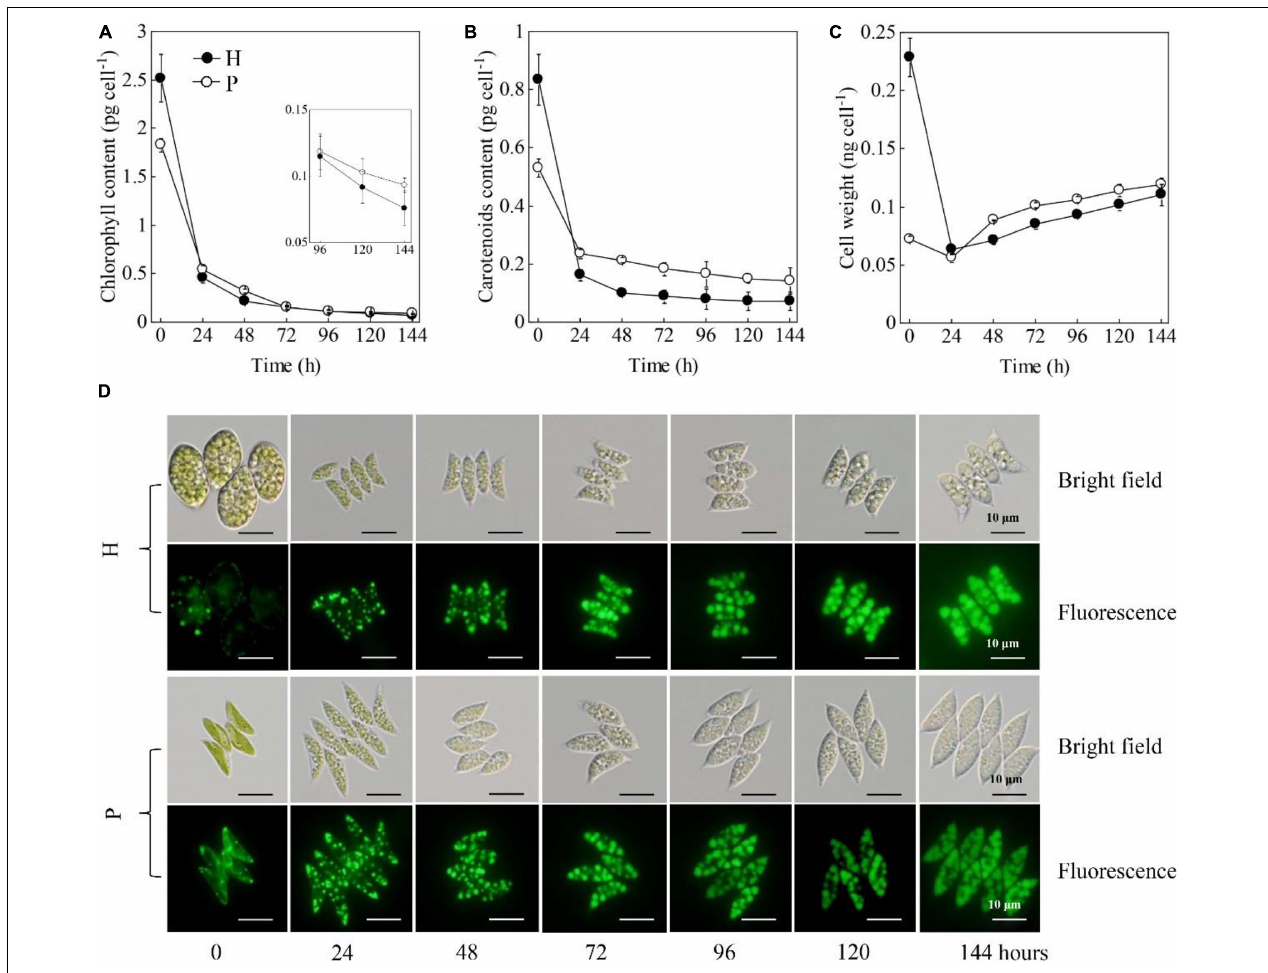
FIGURE 2 | Changes in chlorophyll contents (A) , carotenoids contents (B) , cell weights (C) , cell morphologies and lipid bodies (D) of the heterotrophically (H)- and photoautotrophically (P)-grown S. acuminatus cells subjected to the high-light and N-limited conditions. Intracellular lipid bodies were stained using BODIPY (green). Scale bar = 10 µ